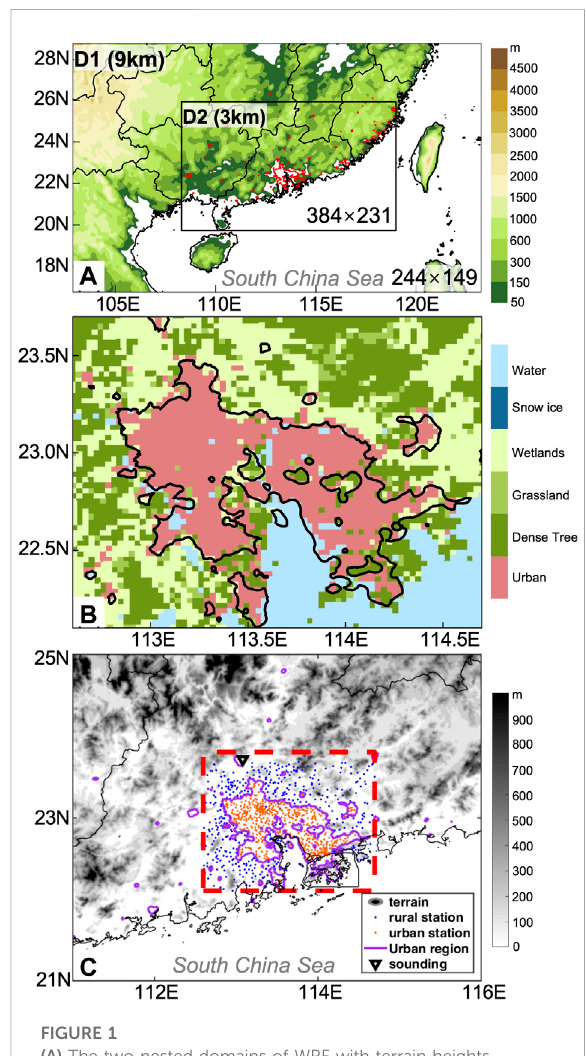
FIGURE 1 (A) The two nested domains of WRF with terrain heights (shadings). The urban areas (red isopleths) are identi fi ed by the DMSPnighttimelightdatain2013.Thegridpointineachdomainis indicated on the bottom right. (B) Enlarged Greater Bay Area. The shadings denote the type of underlying surface. The black contours are the urban areas shown in (A) . (C) Distribution of observations within the key region. The colored dots are the AWS over the key region (red-dashed box; the region in (B) ), with orange (blue) dots indicating stations over the urban (rural) region. The blackinverted triangledenotesthelocationofthesoundingat Qingyuan. The shadings indicate the terrain heights. The magenta contours are the urban areas in (A)